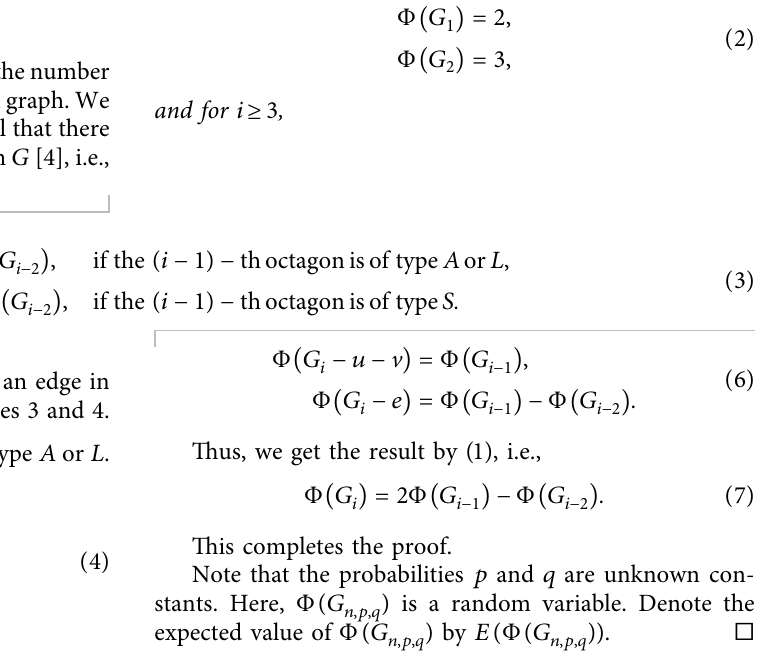
Figure 2: Three types of internal octagons. (a) A . (b) L . (c) S